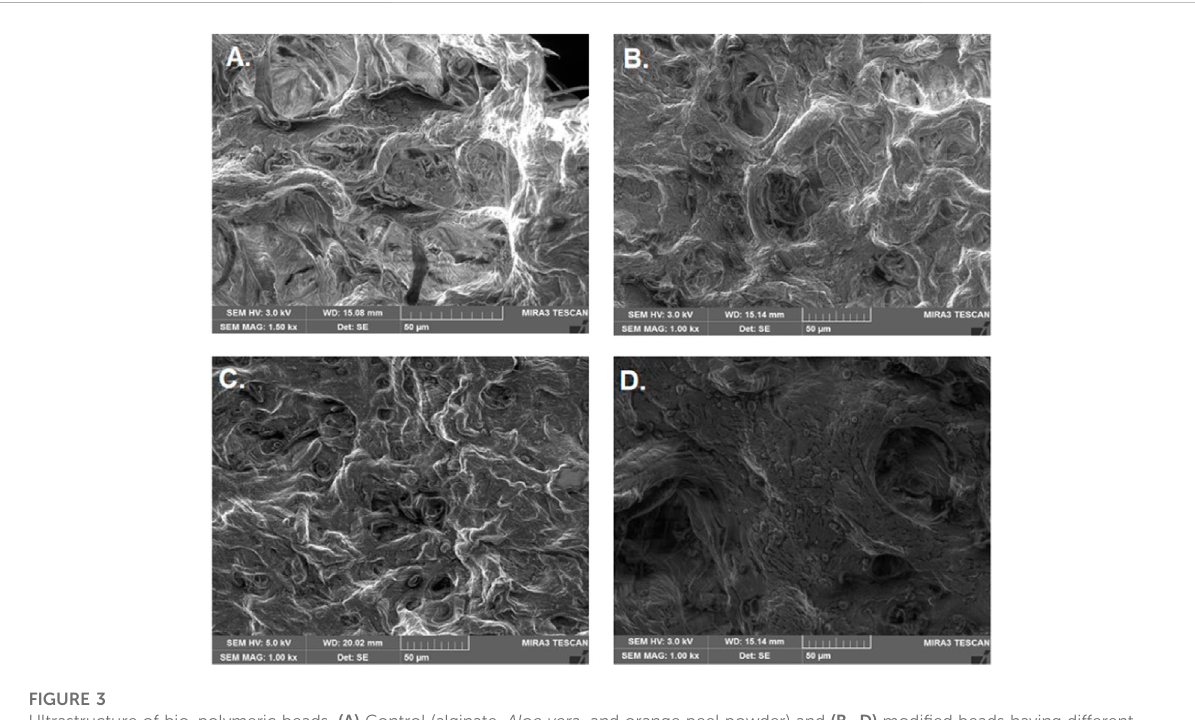
FIGURE 3 Ultrastructure of bio-polymeric beads. (A) Control (alginate, Aloe vera , and orange peel powder) and (B – D) modi fi ed beads having different concentrations of ESMP (1, 3, or 5 mg).